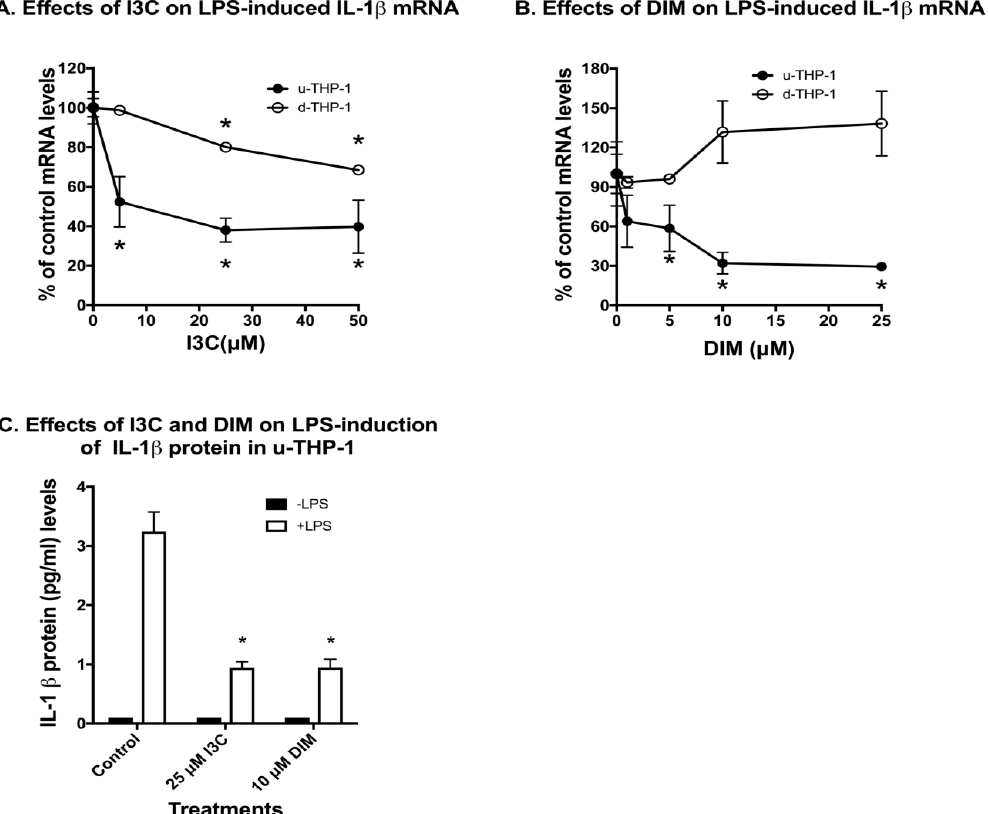
Figure 1. Effects of indole-3-carbinol (I3C) and 3,3 ′ -diindolylmethane (DIM) on lipopolysaccharide (LPS) induction of IL-1 β mRNA and protein levels in THP-1 cells. THP-1 cells were differentiated